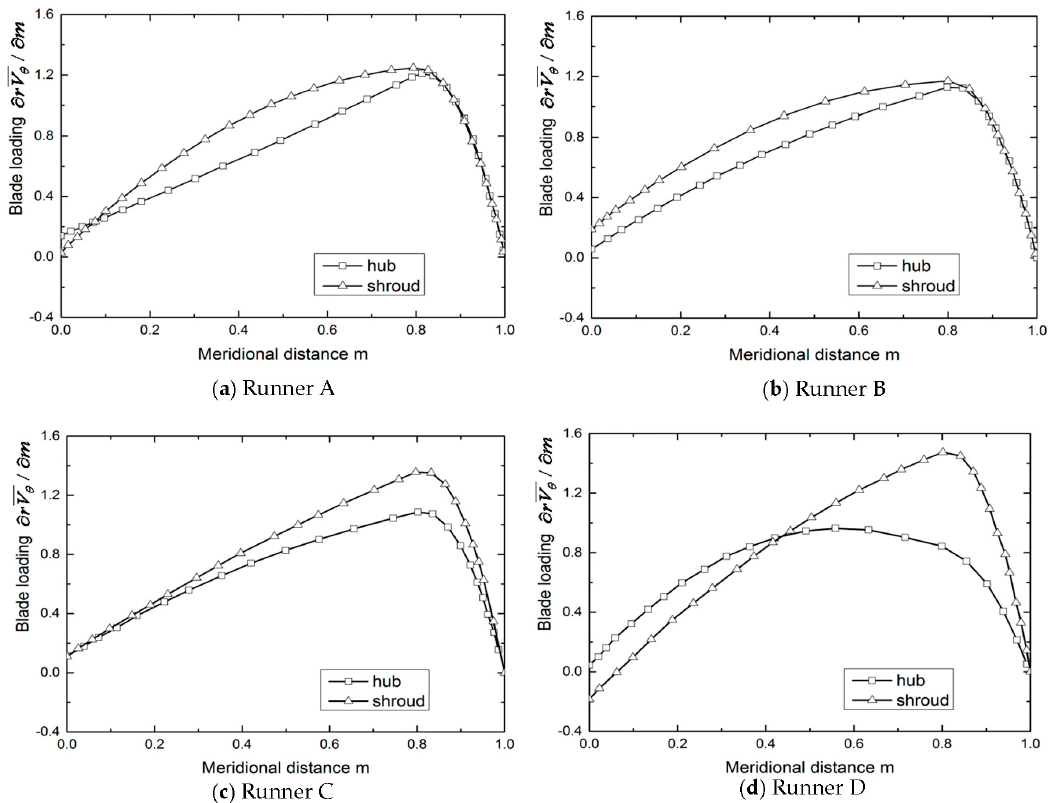
Figure 12. Blade loading distributions for runners A–D.